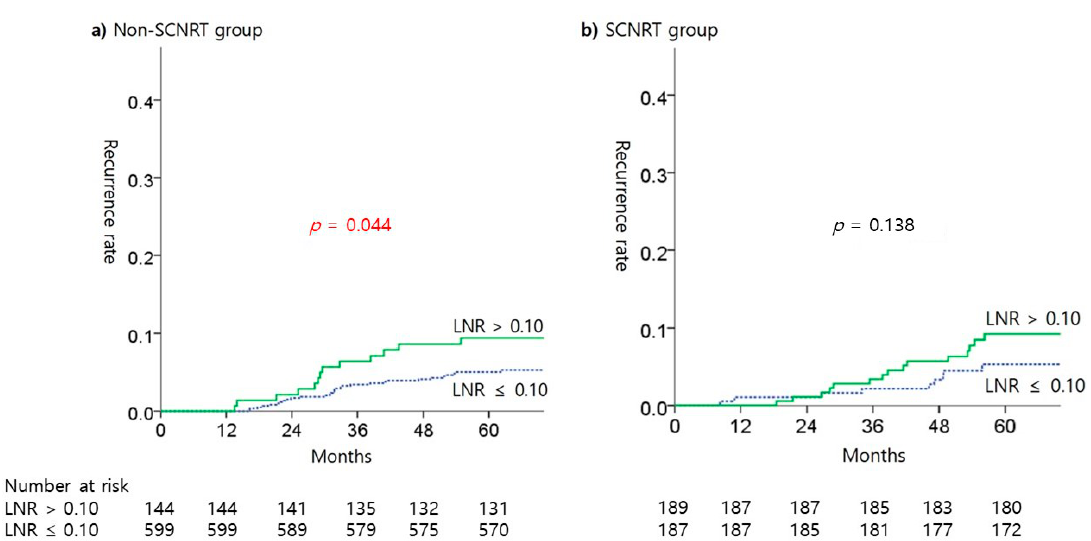
Table 4. Multivariate analysis of disease ‐ free survival.